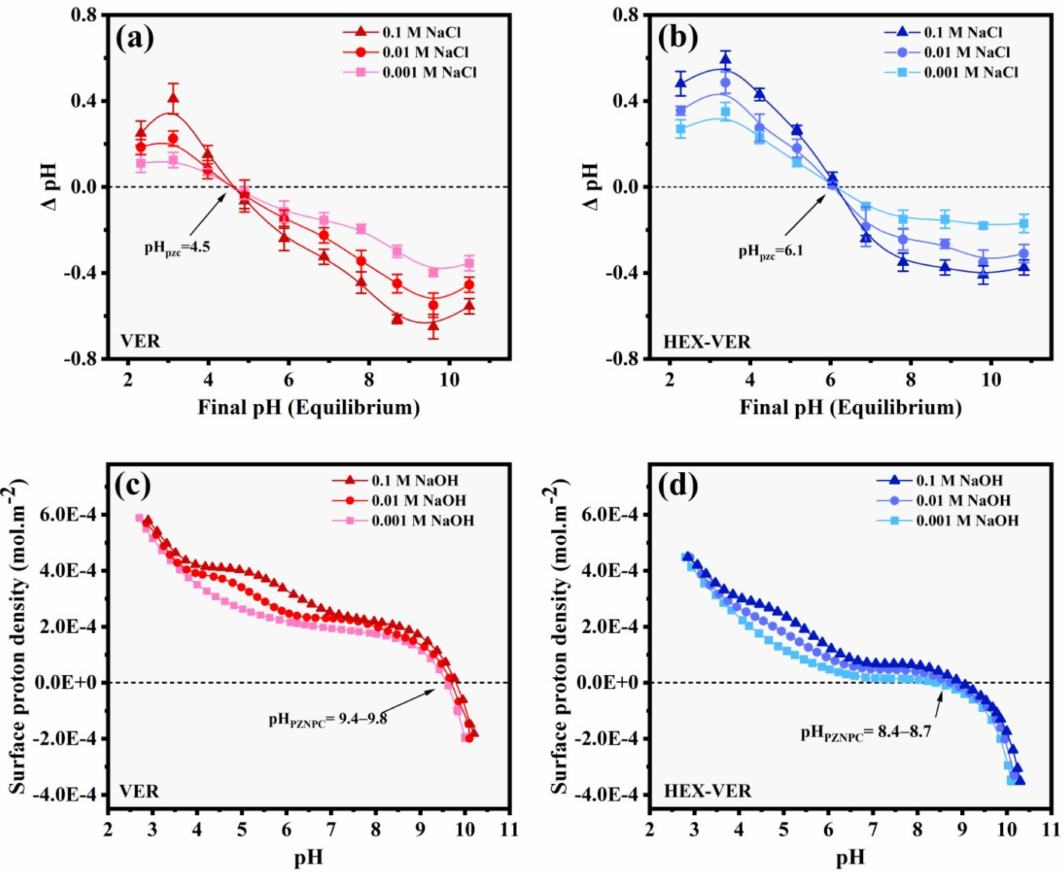
Figure 2. The potentiometric titration curves of pH pzc for VER ( a ), and HEX–VER ( b ) in the pH range (2–11) at ionic concentration of 0.1, 0.01 and 0.001 M of NaCl; surface proton density/Surface charge of the VER ( c ), and HEX–VER ( d ) in the pH range (2.7–10.4) at ionic concentration of 0.1, 0.01 and 0.001 M of NaOH; Temp 25 ◦ C. Surface proton density of VER ( c ) and HEX–VER ( d ) at 0.1, 0.01 and 0.001 M NaOH ionic concentrations; temperature: 25 ◦ C; pH: